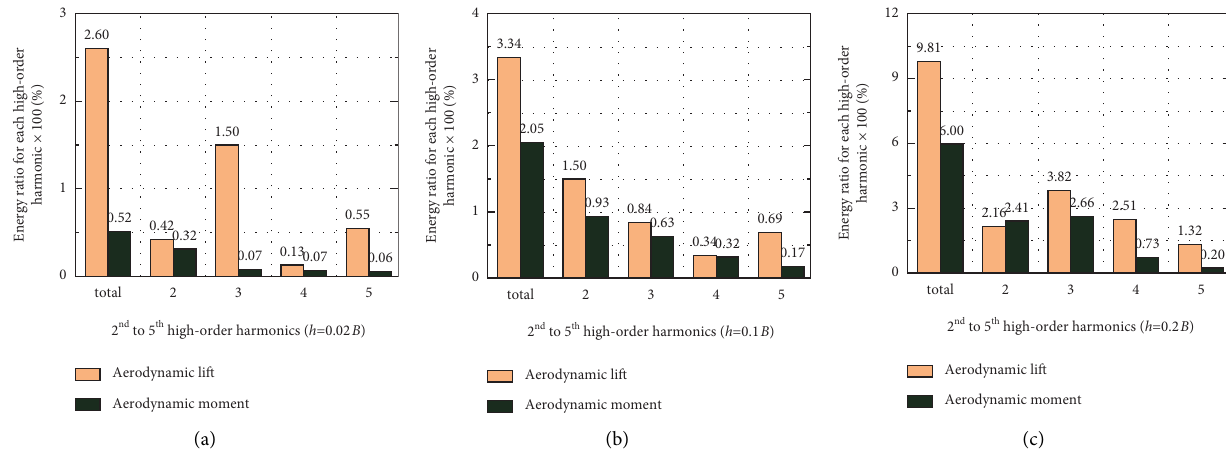
Figure 13: Proportion of high-order harmonics under different vertical amplitude vibrations of the single